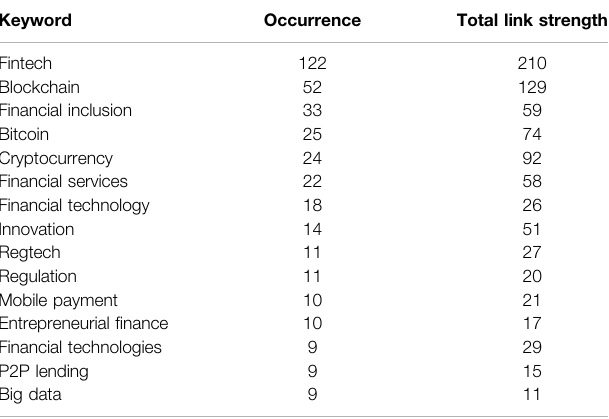
TABLE 2 | Occurrence of keywords in the network. Keyword